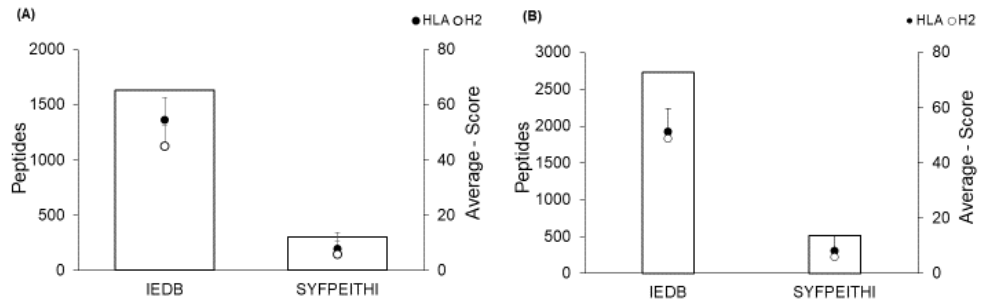
Figure 1. Number of predicted epitopes with major histocompatibility complex (MHC) class I interaction for murine H2Db and human HLAA*0201 haplotypes. Prediction of of the homolog of receptors for activated C kinase (LACK) ( A ) and phosphoenolpyruvate carboxykinase (PEPCK) ( B ) epitopes in the IEDB and SYFPEITHI servers. The histogram shows the number of peptides (left axis), and the bullets show each server ’ s mean scores ± SD (right axis).